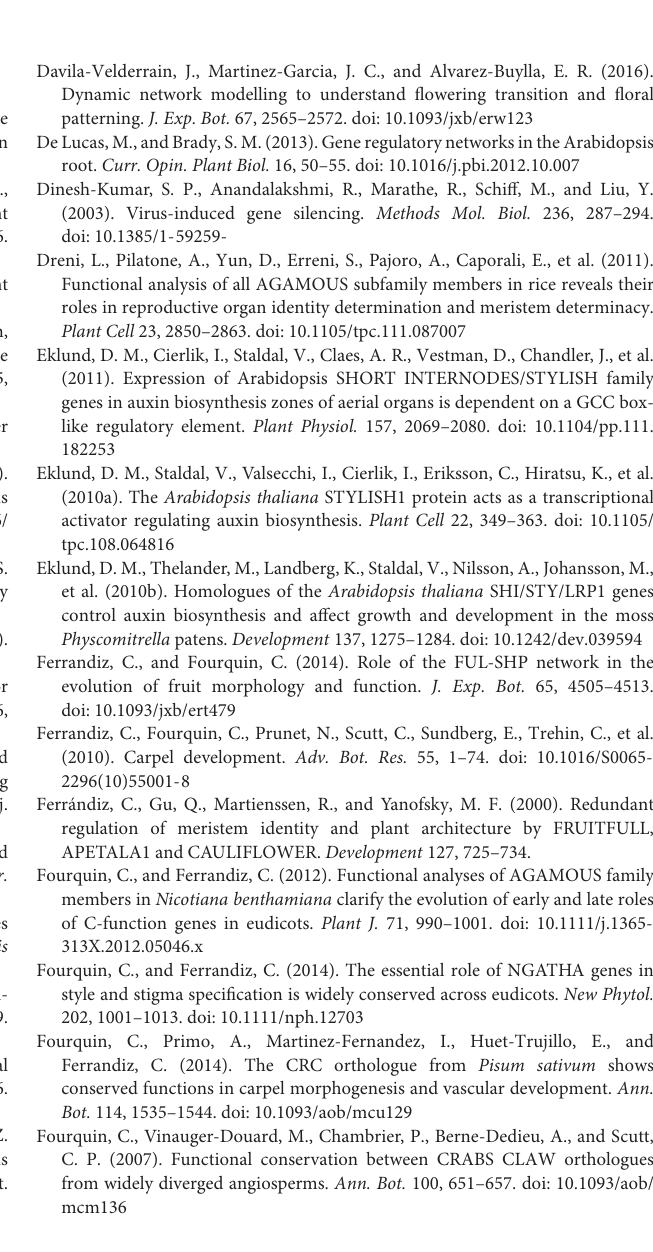
FIGURE S5 | Pistils of E. californica wildtype or EsSRS-L-VIGS treated plants (top panels). Expression level by real-time PCR analysis of EcSRS-L in TRV2-EcSRS-L flowers. The error bars depict the s.e. based on two biological replicates. TABLE S1 | Protein similarity and identity matrix between Arabidopsis, E. californica and N. benthamiana SHI/STY/SRS proteins generated by MUSCLE (PAM 200). TABLE S2 | Primers used in this